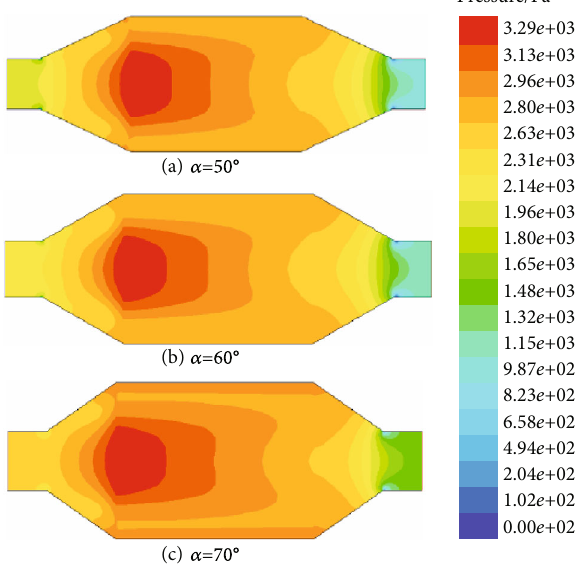
Figure 6: Pressure distribution of the diesel particulate fi